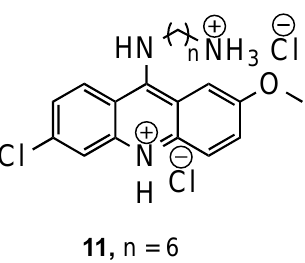
Figure 6. Most active compound 11 developed by Guetzoyan and co-workers [16].